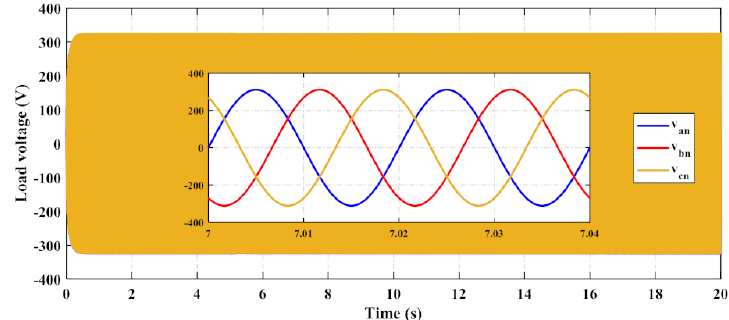
Figure 21. Load instantaneous voltage using BSS +